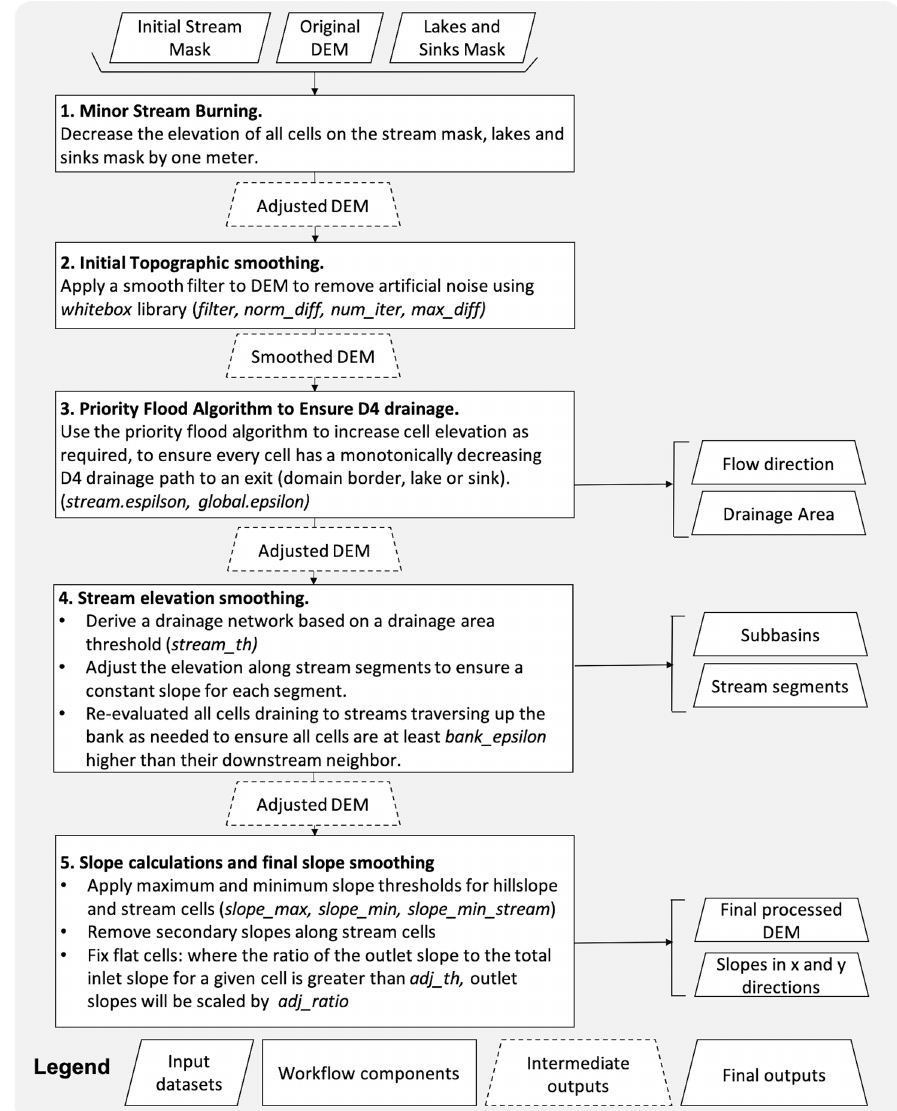
Figure 2. Workflow diagram outlining the major processing steps used and the outputs generated; input parameters are listed in italics and described in more detail in Table